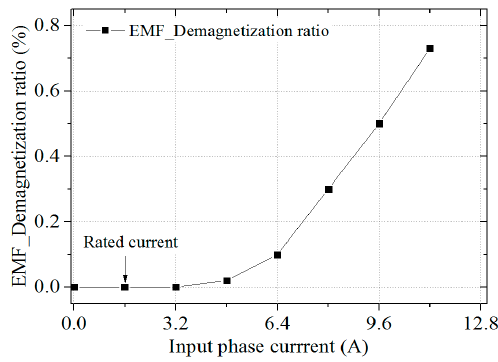
Figure 18. EMF demagnetization ratios of the optimized model.